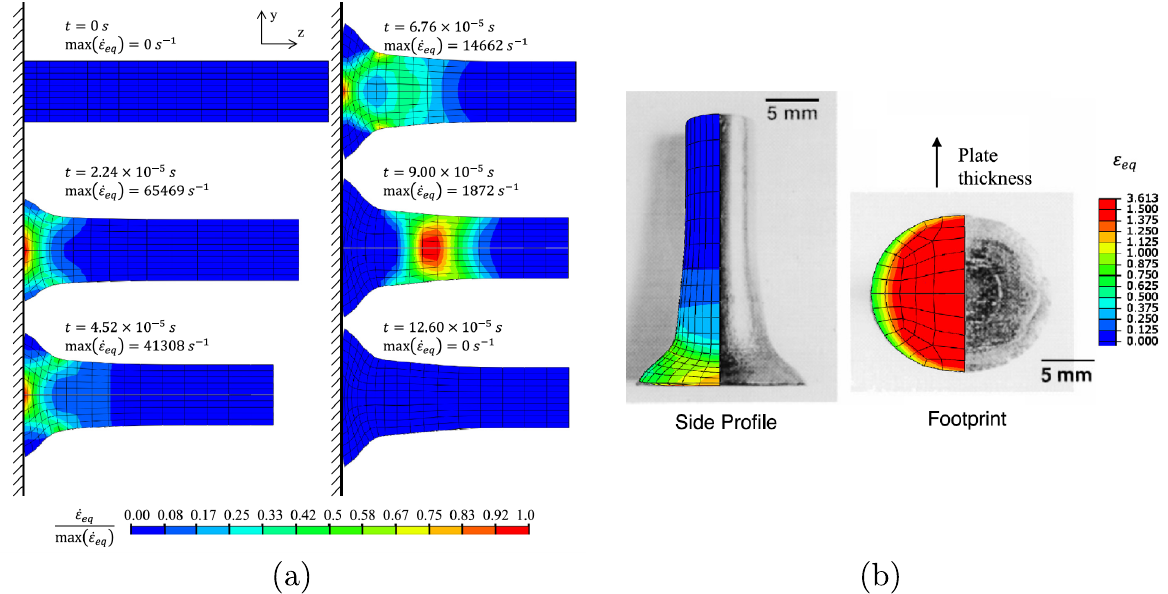
Figure 10. Simulation results of Taylor impact test for Ta cylinder: ( a ) equivalent plastic strain rate contour at different time step; ( b ) comparison of the measured and simulated cylinder geometry after the impact with the superimposed contours of equivalent plastic strain. Reproduced from [179], under